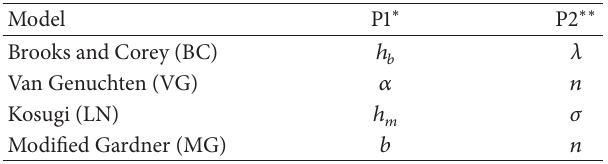
Table 1: Parameters of the SWCC models.